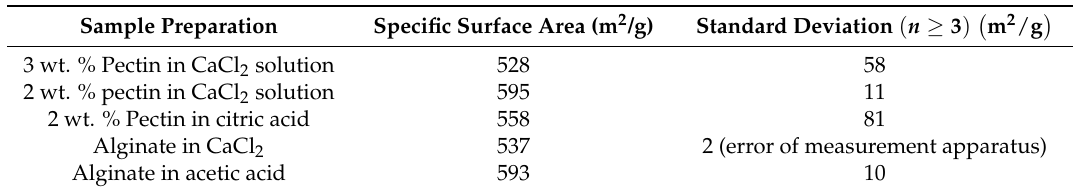
Table 5. Average specific surface areas of produced aerogel particles.